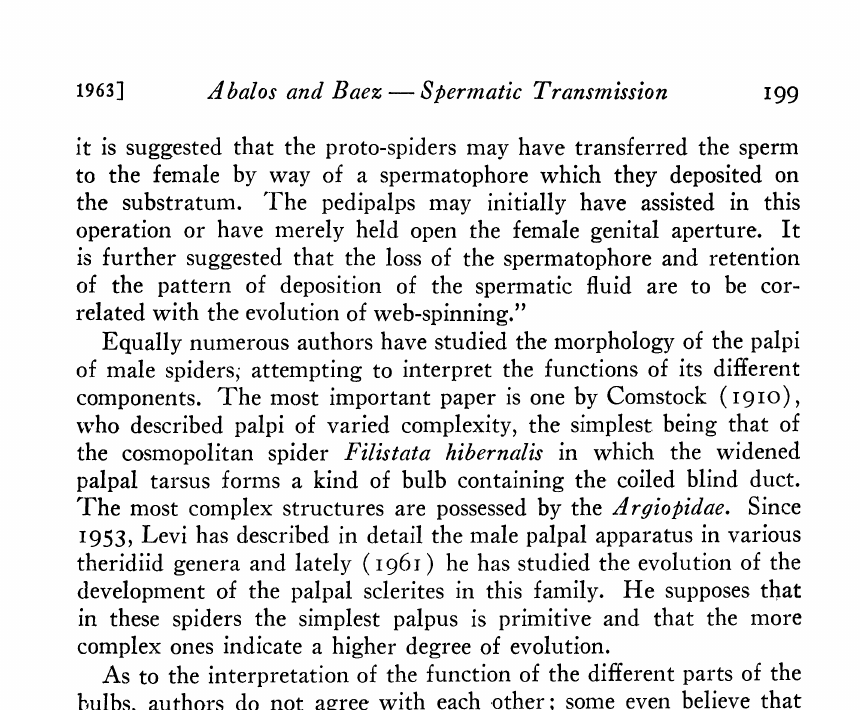
Figs. 1-3. Latrodectus geometricus. Fig. 1. Seminal receptacle with male apical element. Fig. 2. Place of separation of apical element. Fig. 3. Complete embolus. -Baez del. Figs. 4-11. ,MeteIeira sp. Fig. 4. Seminal receptacle with male apical element. Fig. 5. Seminal receptacle with two apical elements. Figs. 6, 7. Loca- tion of apical element in the palpusMArliopid species. Fig. 8. Seminal receptacle with apical element. Fig. 9. Apical element Metepeira candida. Fig. 10. Seminal receptacle with apical element. Fig. 11. Apical element. -Baez